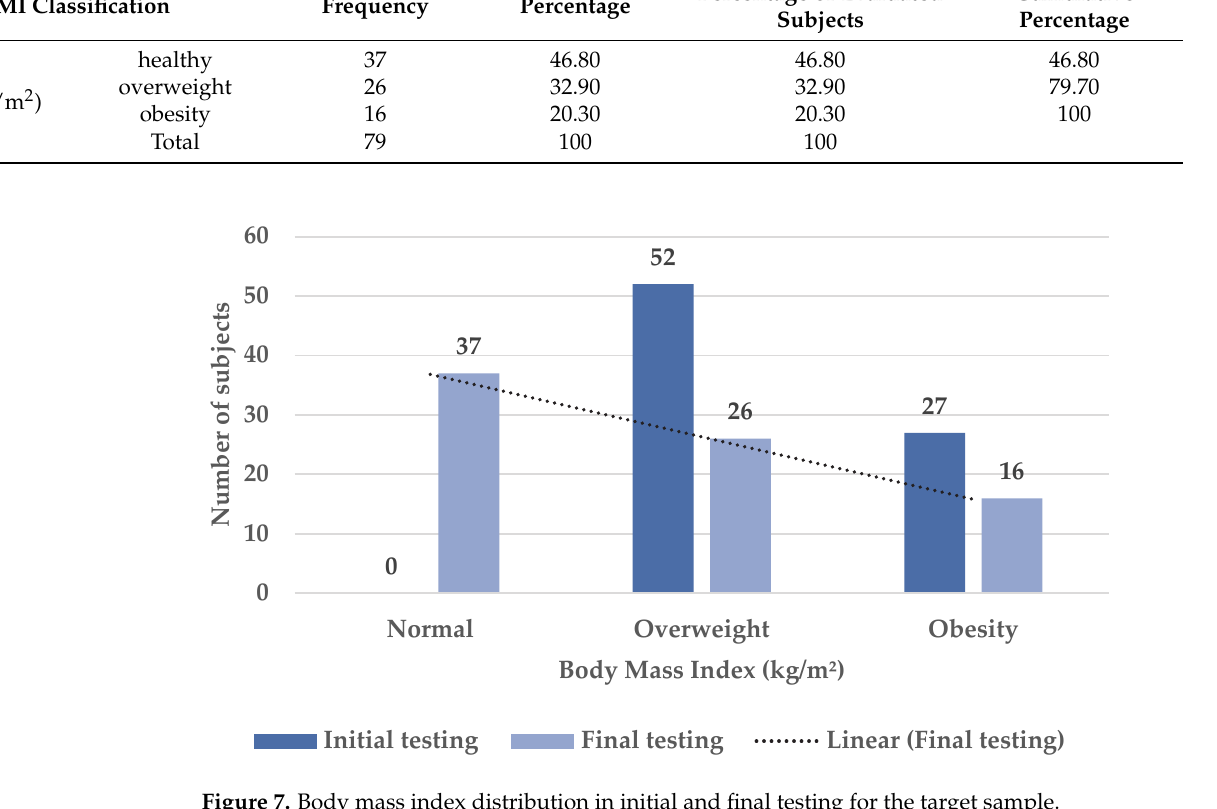
Figure 7. Body mass index distribution in initial and final testing for the target sample.